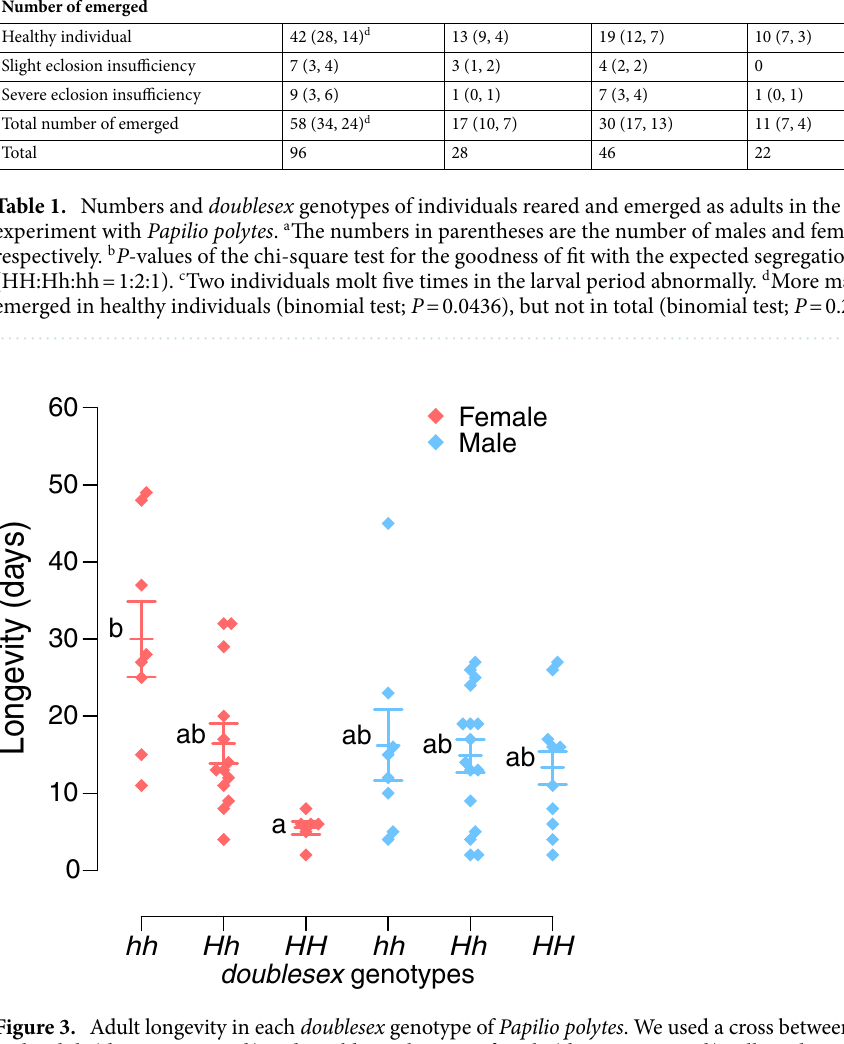
Figure 3. Adult longevity in each doublesex genotype of Papilio polytes . We used a cross between a wild-caught male adult ( dsx genotype, Hh ) and a wild-caught virgin female ( dsx genotype, Hh ) collected as a pupa. Red plots, females; blue plots, males. Middle bar represents mean, and upper and lower bars indicate standard error. Different letters indicate significant differences between groups (Tukey post hoc test, P < 0.05; Supplementary Table